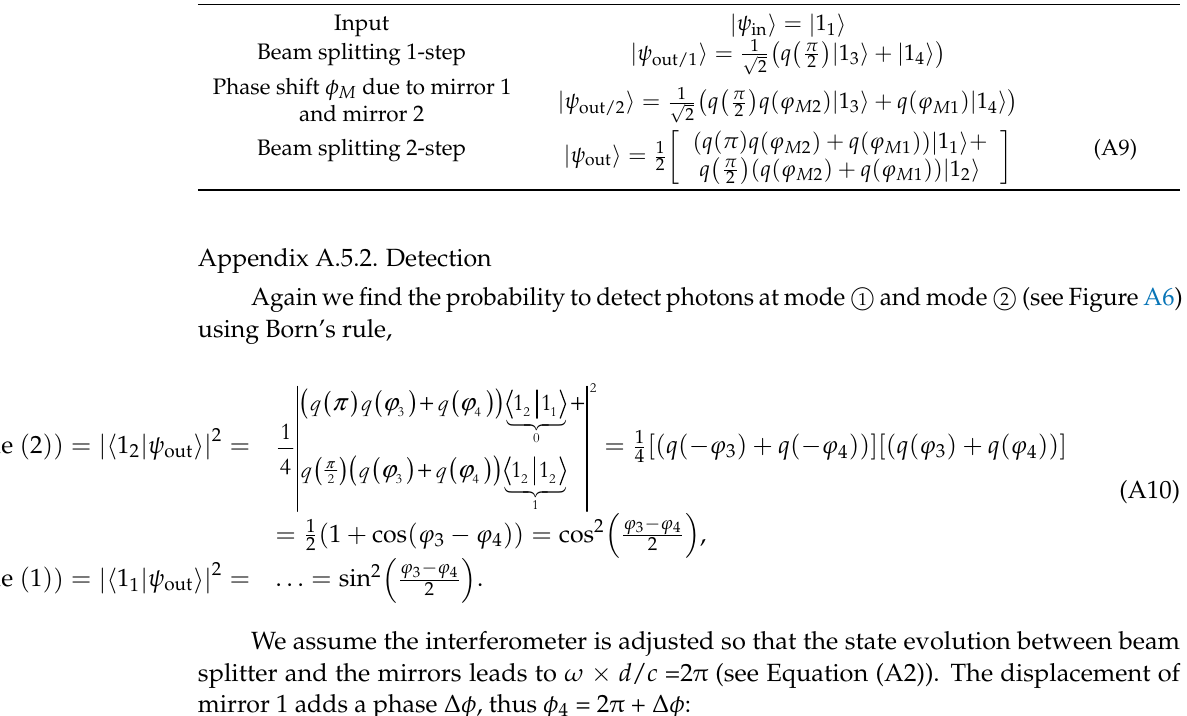
Figure A6. Pointer representation of single photon interference from a Michelson interferometer the  Mi . transformation | ψ in  → | ψ out  is mediated by the matrix We assume the interferometer is adjusted so that the state evolution between beam splitter and the mirrors leads to ω × d / c =2 π (see Equation (A2)). The displacement of mir- ror 1 adds a phase Δ ϕ , thus ϕ 4 = 2 π + Δ ϕ : This results expectedly gives the quantum interference pattern from Figure 3b. Quan- tum interference means, interference without waves. The experiment demonstrates trans- parent experimental evidence of the phase sensitivity of the probability amplitudes. The total probability, summed over the output modes equals one, as it should be. The pointer representation of Equation (A9) (Figure A6) illustrates this result: Adding the pointers gives the total quantum state, calculating the square of the pointer length gives the prob- ability. References